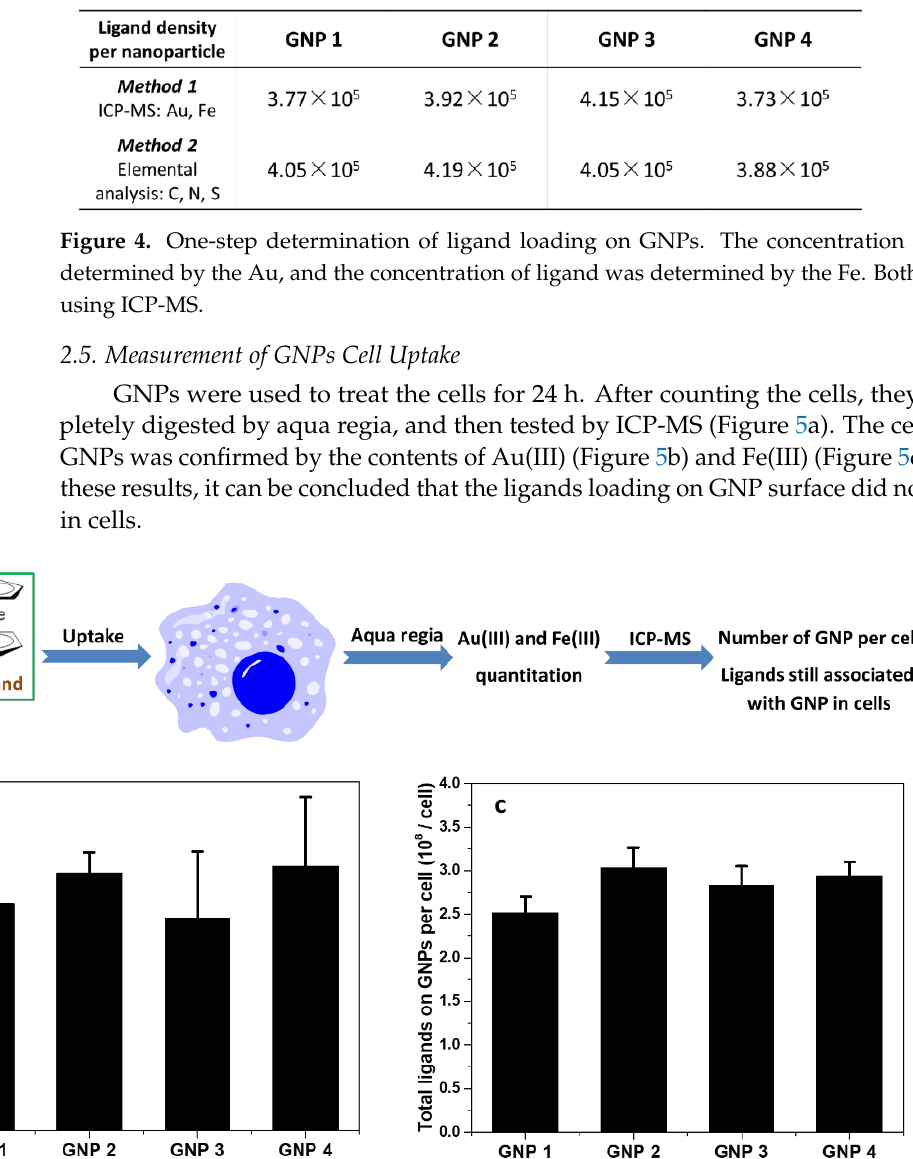
Figure 5. Cell uptake of GNPs. Cell uptake of A549 cells treated with GNPs. After treatment with GNPs (5 μg/mL) 24 h, cells were digested by aqua regia, and the content of Au(III) and Fe(III) was measured by ICP-MS. Error bars indicate mean ± standard deviation (n = 3). ( a ) The samples were digested by aqua regia and then tested by ICP-MS. ( b ) Based on the content of Au(III), the uptake of GNPs in cells was reflected. ( c ) Based on the content of Fe(III), the uptake of GNPs surface ligands in cells was reflected.